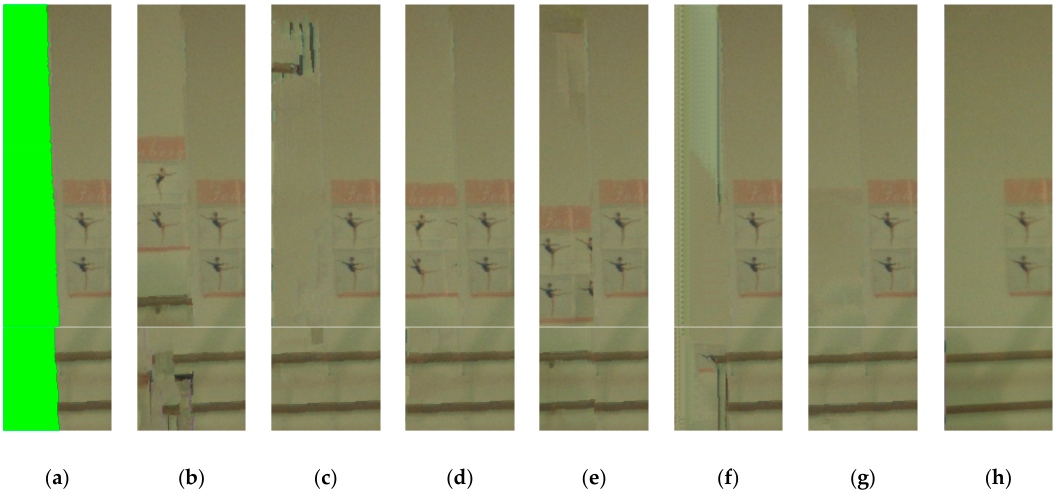
Figure 12. OFRs filling results: ( a ) OFRs after DIBR; ( b ) Criminisi’s method; ( c ) Daribo’s method; ( d ) Lei’s method; ( e ) Oliveira’s method; ( f ) Kao’s method; ( g ) the proposed method; and ( h ) ground truth.